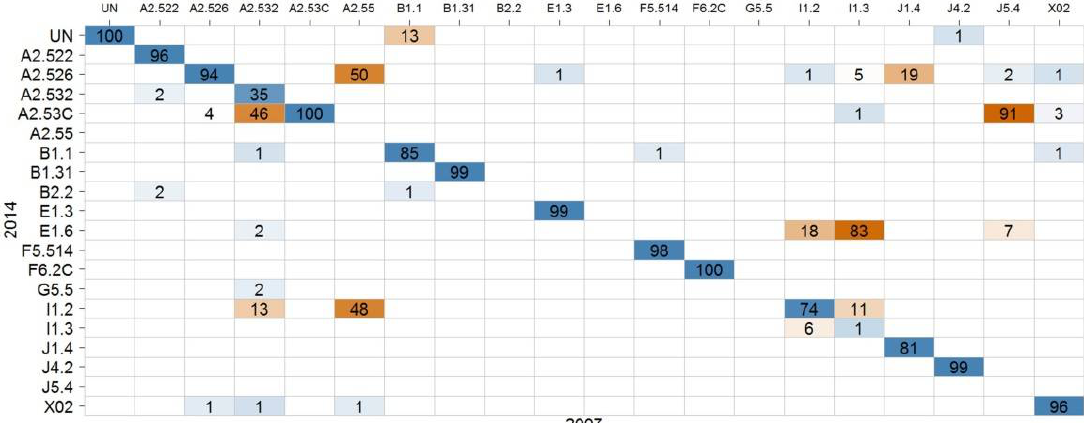
Figure 4. EUNIS habitat class transition matrix from 2007 to 2014 for the SC site.